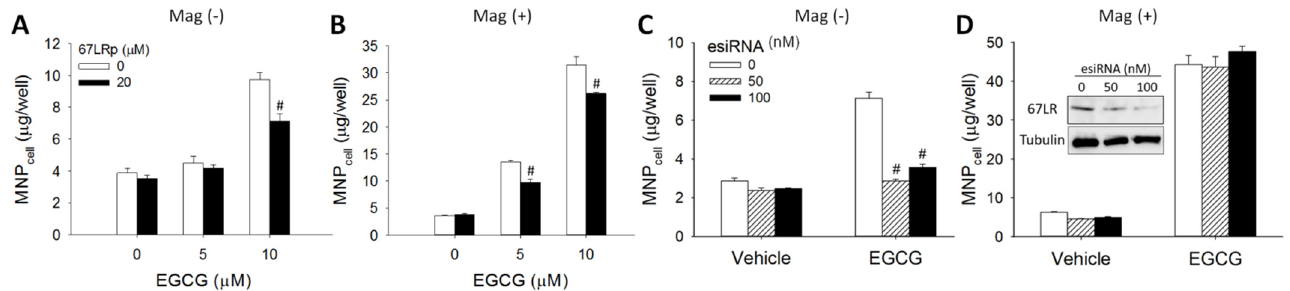
Figure 4. Peptide of 67LR (67LRp) and 67LR knockdown attenuated the effects of EGCG on MNP uptake by LN-229 cells. ( A , B ) LN-229 cells were incubated with 50 µ g/well of dextran-MNPs, EGCG (5 or 10 µ M), and 67LRp (20 µ M) for 6 h. ( C , D ) After transfection with esiRNA (50 or 100 nM), LN-229 cells were incubated with 50 µ g/well of CMX-MNPs and EGCG (10 µ M) for 2 h. The incubation was conducted in the absence (Mag − ; ( A , C )) or presence (Mag+; ( B , D )) of the magnet. The 67LR expression was determined 96 h after transfection with esiRNA using western blotting (( D ) insert). Values are mean ± SEM ( n = 4). # , p < 0.05 compared with the corresponding control group.